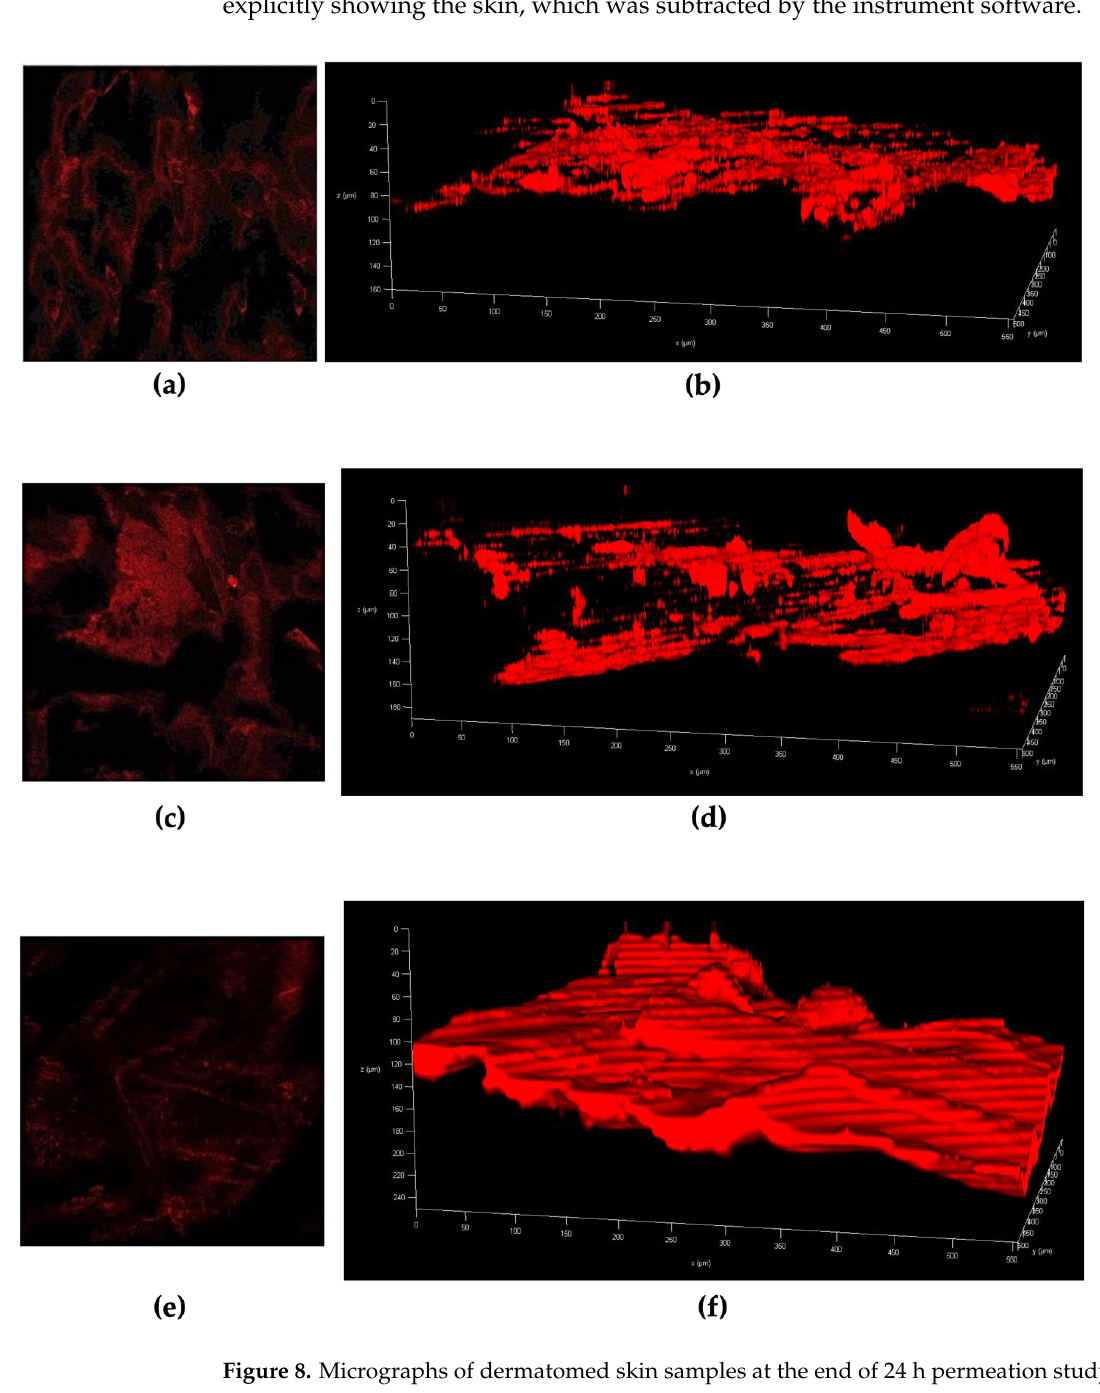
Figure 8. Micrographs of dermatomed skin samples at the end of 24 h permeation study acquired by multiphoton microscopy. ( a ) RB solution (RB-S), stratum corneum; ( b ) RB-S, 3D visualisation; ( c ) RB-loaded aqueous cream BP (RB-C), stratum corneum; ( d ) RB-C, 3D visualisation; ( e ) RB-loaded TF dispersion (RB-TF), stratum corneum; and ( f ) RB-TF, 3D